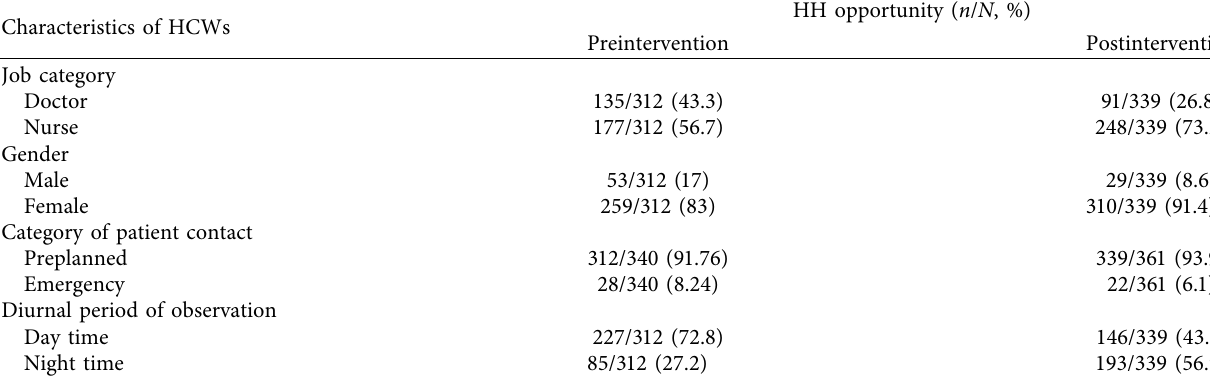
Table 1: Frequency and characteristics of patient contacts.